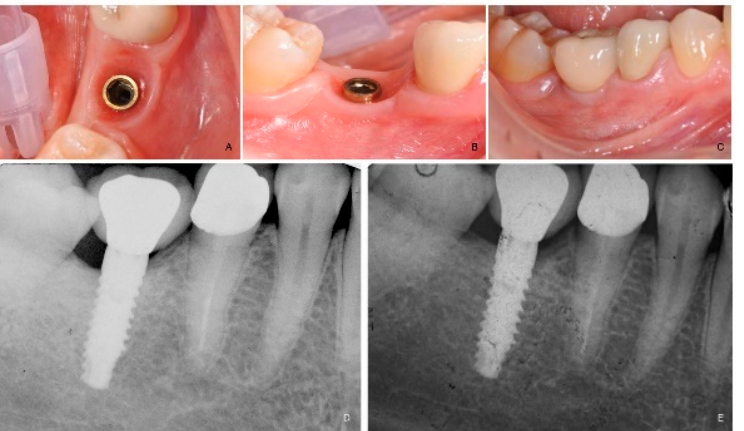
Figure 3. ( A ): Intraoral occlusal view of the implant immediately before prosthesis delivery at tooth number 46. ( B ): Intraoral lateral view of the implant immediately before prosthesis delivery. ( C ): Intraoral lateral view at one year after loading follow-up. ( D ): Periapical radiograph at prosthesis delivery. ( E ): Periapical radiograph at one year after loading follow-up.